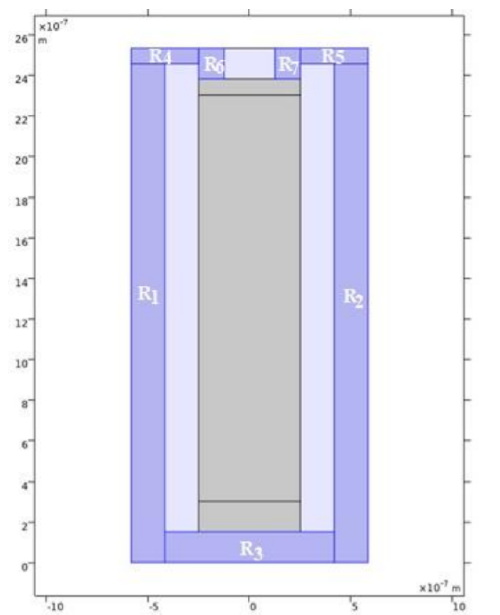
Figure 22. Short-circuited solar cell model (gray: Si PIN junction; dark blue: aluminum; light blue: